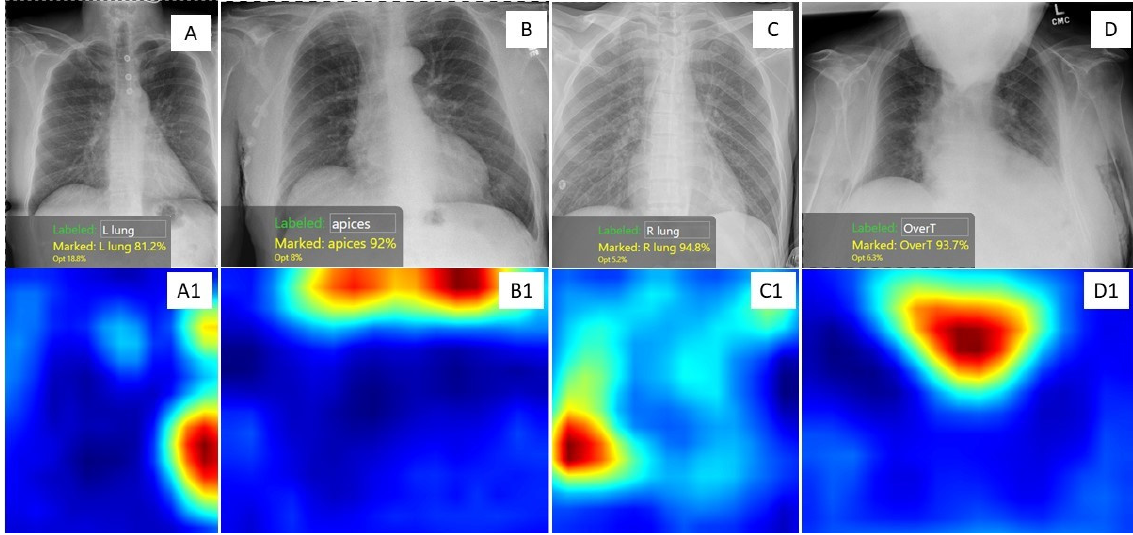
Figure 2. CXRs and corresponding heat maps of four adult patients demonstrating various causes of suboptimal CXRs. The heat maps were produced by four of our AI models built on the Cognex Platform. ( A ) CXR with clipped left costophrenic angle was identified as red areas on heat map image A1 ; ( B ) Suboptimal CXR with non-inclusion of lung apices was marked in red color on heat map image B1 ; ( C ) Suboptimal CXR with clipped right costophrenic angle was identified as a red area on heat map image C1 ; ( D ) Suboptimal CXR due to patient's chin obscuring lung and mediastinum was identified as a red region on heat map image D1 .